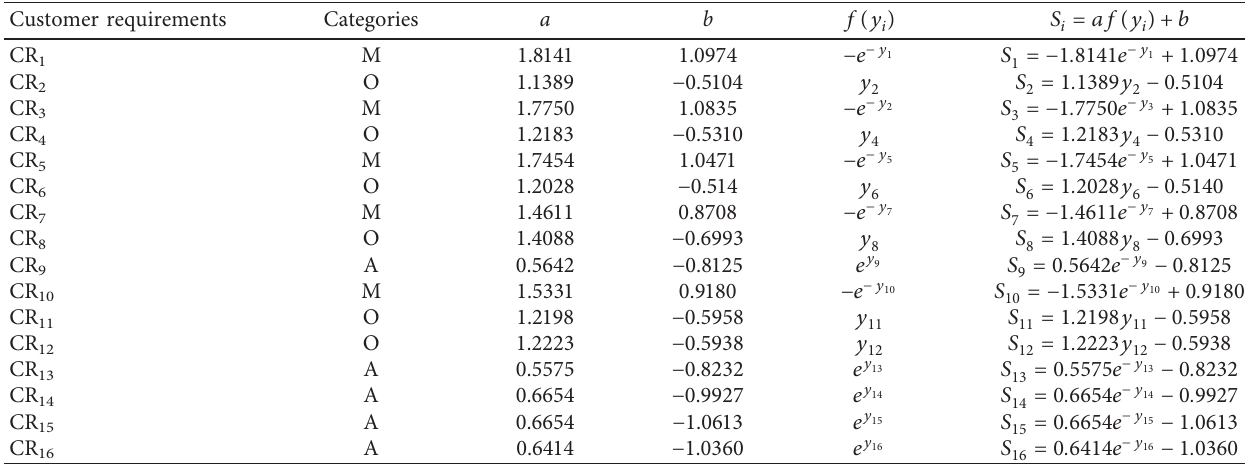
Table 3: S-CR relationship fitting function.